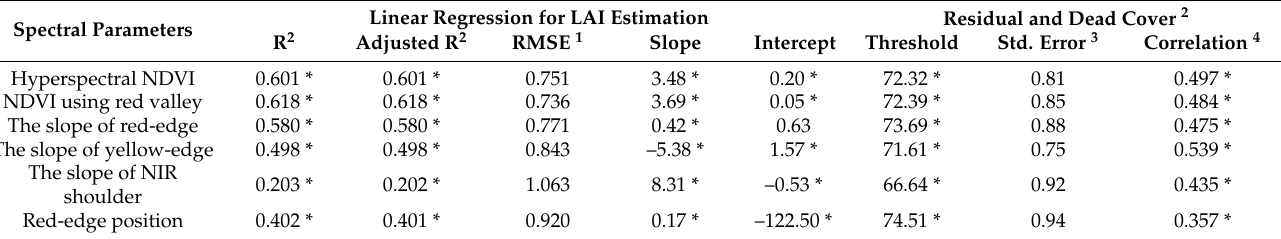
Table 4. The impact of dead cover on LAI estimation by different spectral parameters. Linear Regression for LAI Estimation Residual and Dead Cover Spectral Parameters